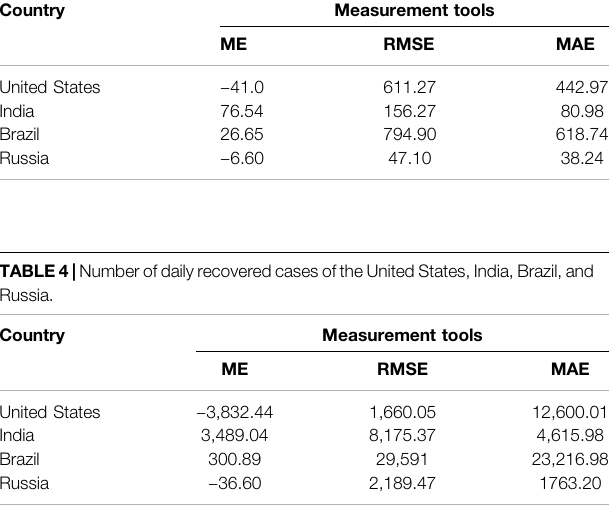
TABLE. 1 | Evaluation measurement tools. Criterion Formula